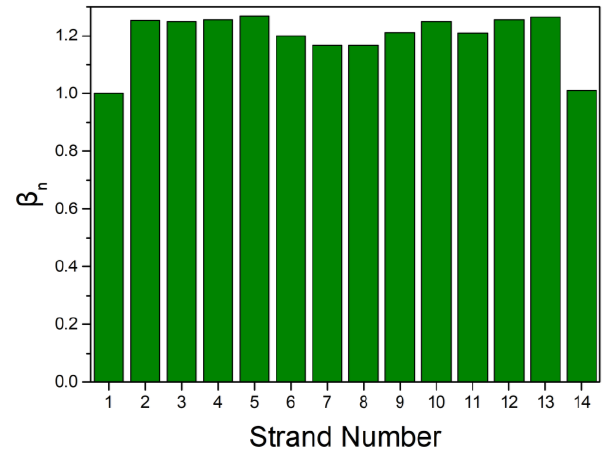
Figure 8. Modeling results of β n distribution of LIB strands.